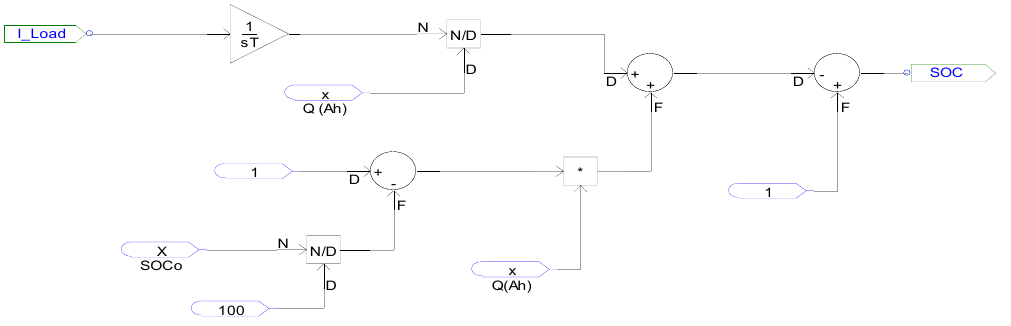
Figure 8. Model for current integration ‐ based SOC estimation.